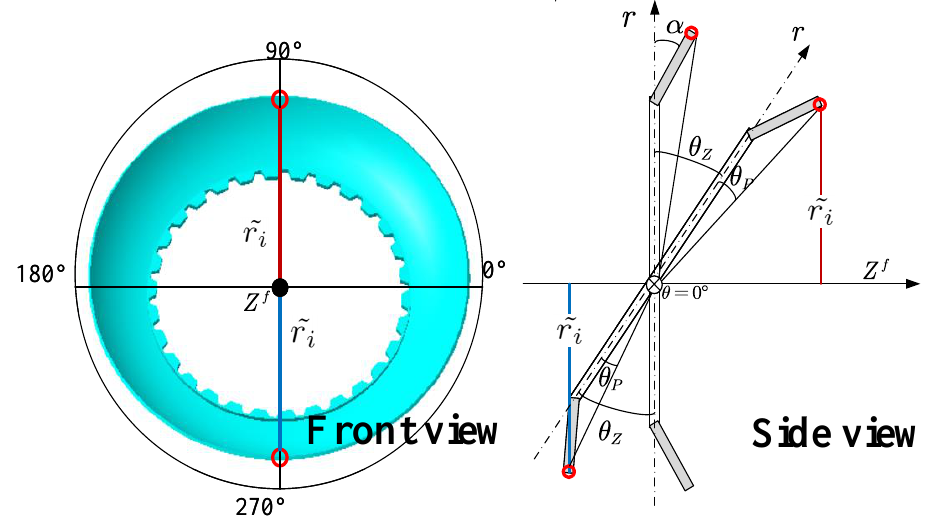
Figure 6. Deformation-induced inclined